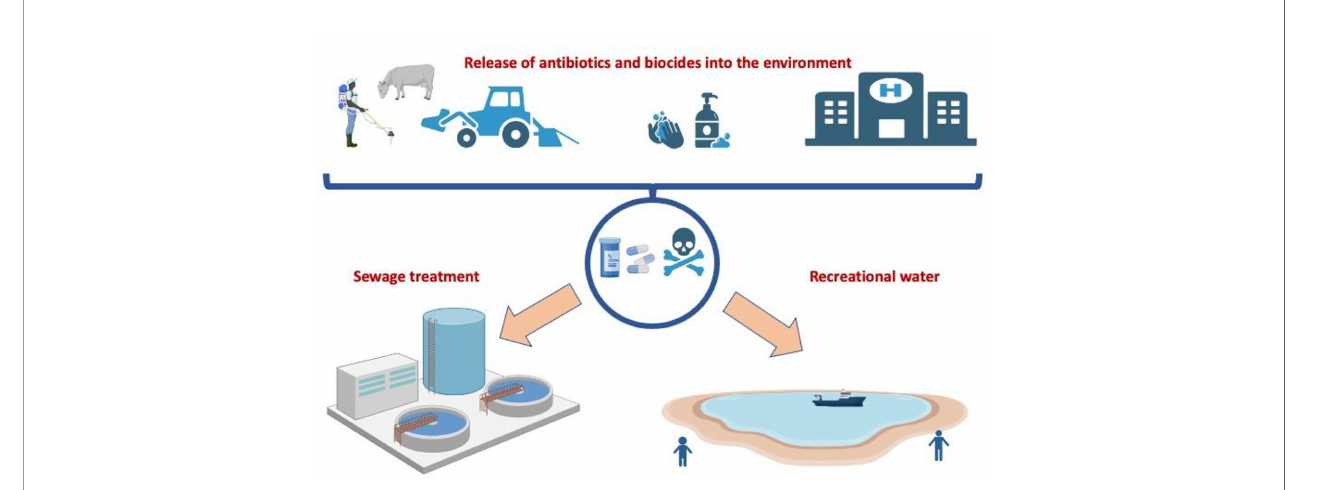
FIGURE 3 | Impact of COVID-19 on the release of antimicrobials into the environment. The excessive use of antimicrobial drugs in farm animals and human medicine, especially in hospitals, can lead to an increase in the concentration of biocides and disinfectants in wastewater and sewage treatment plants and cause the selective survival of bacterial strains carrying resistance